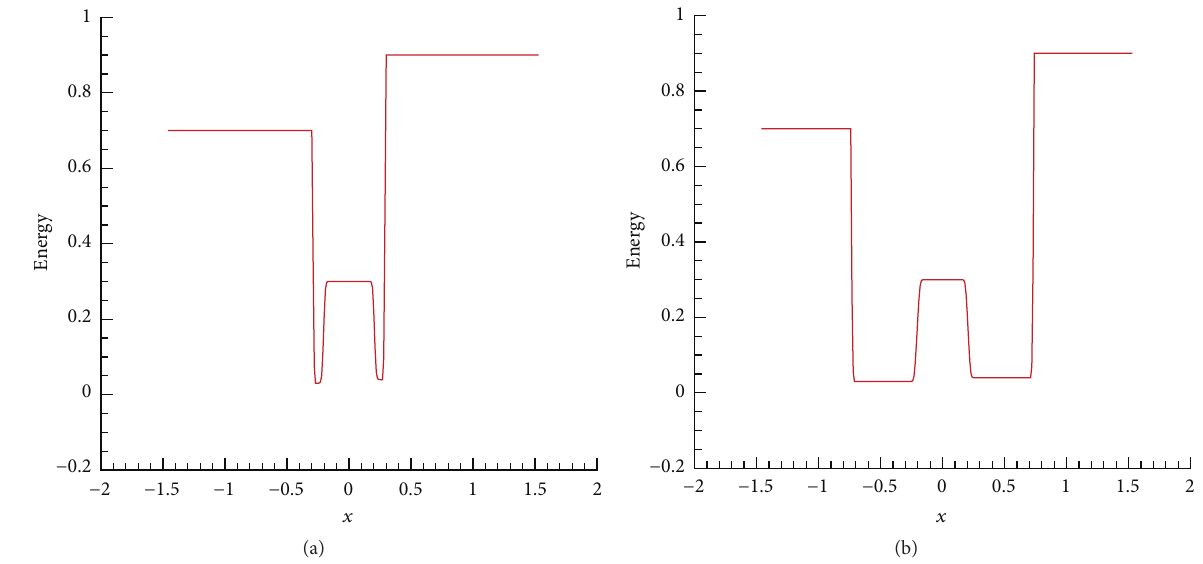
Figure 16: Numerical results of 𝐻 at 𝑡 = 0.8 (a) and 𝑡 = 5 (b) for Data